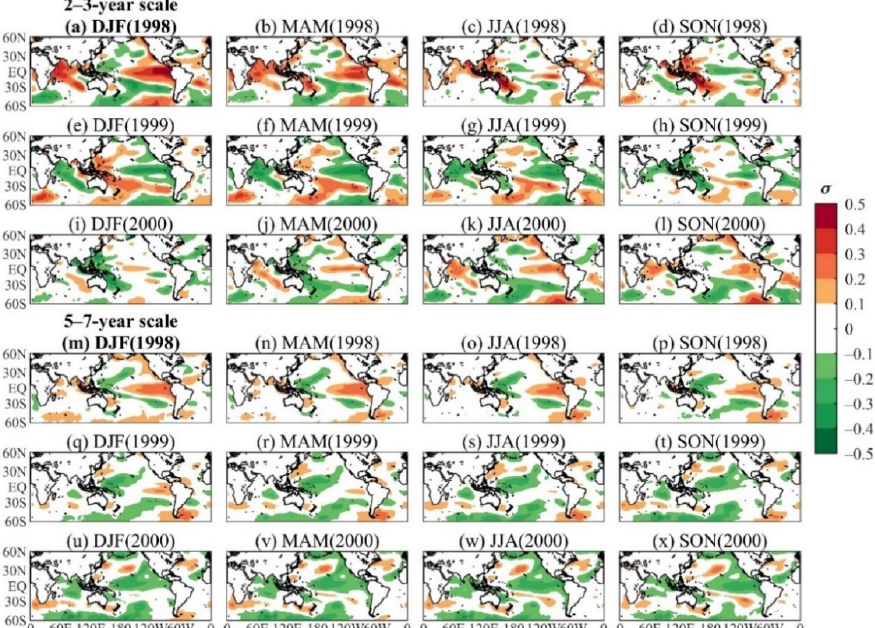
Figure 7. Seasonal sea surface temperature anomalies filtered at ( a – l ) biannual 2–3-year and ( m – x ) interannual 5–7-year scales between DJF 1998 and SON 2000.